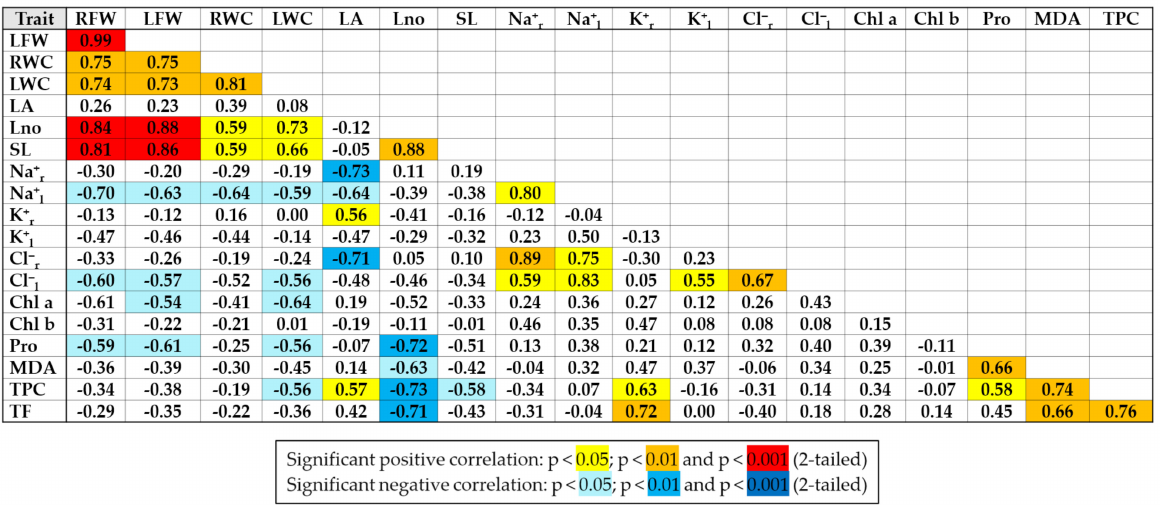
Figure 9. Pearson correlations between the main characteristics analysed in E. bonariensis and E. sumatrensis , on the ensemble of the experiment. Abbreviations: RFW—fresh weight of roots; LFW— fresh weight of leaves; RWC—water content of roots; LWC—water content of leaves; LA—leaf area; Lno—number of leaves; SL—stem length; Na + r —sodium in roots; Na + l —sodium in leaves; K + r — potassium in roots; K + l —potassium in leaves; Cl − r —chlorine in roots; Cl − l —chlorine in leaves; Chl a—chlorophyll a; Chl b—chlorophyll b; Pro—proline; MDA—malondialdehyde; TPC—total phenolic compounds; TF—total flavonoids.